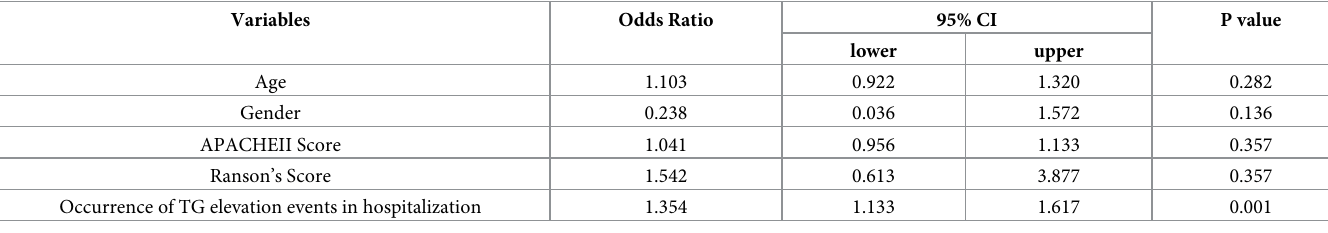
We found that hospital-acquired new-onset TG elevation is associated with mortality. All the patients in N-TG group are non-hyperlipidaemia-induced pancreatitis which ensure the comparability of the study. The elevated TG levels observed in SAP patients with a normal TG level at admission could occur for several reasons. Establishing enteral nutrition in these patients is relatively difficult because of persistent intestinal dysfunction, as well as SAP-related Table 4. Logistic regression analysis of risk factors for mortality in N-TG group